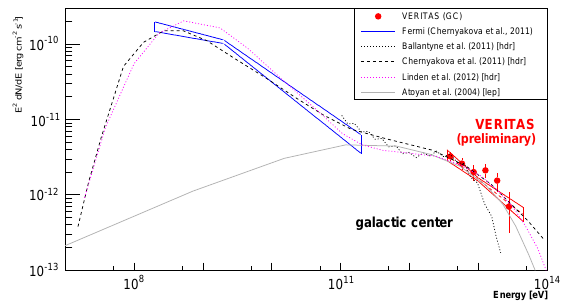
Figure 2: VERITAS energy spectrum compared to hadronic [13, 14, 15] and leptonic [16] emission models discussed for the GC source. The Fermi /LAT bow tie is taken from